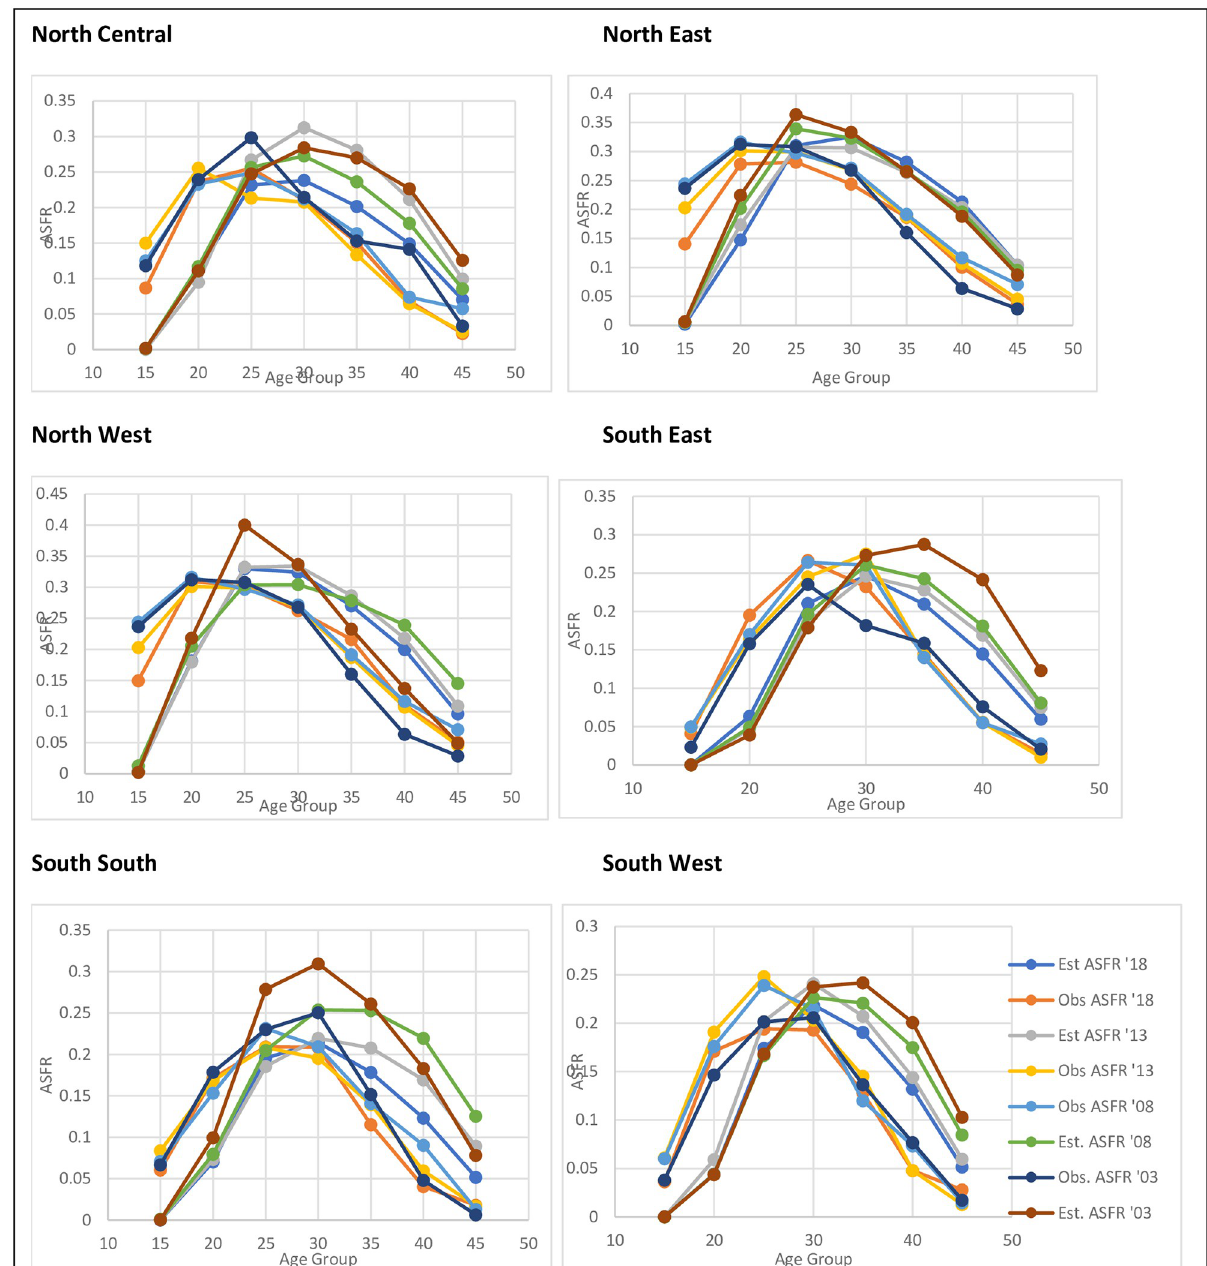
Fig 2. Age specific fertility rates observed and estimated by years,